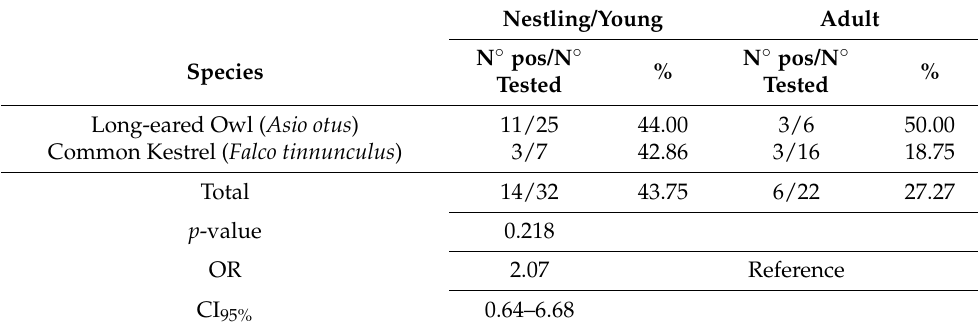
Table 6. Detection of Campylobacter according to the age of birds.